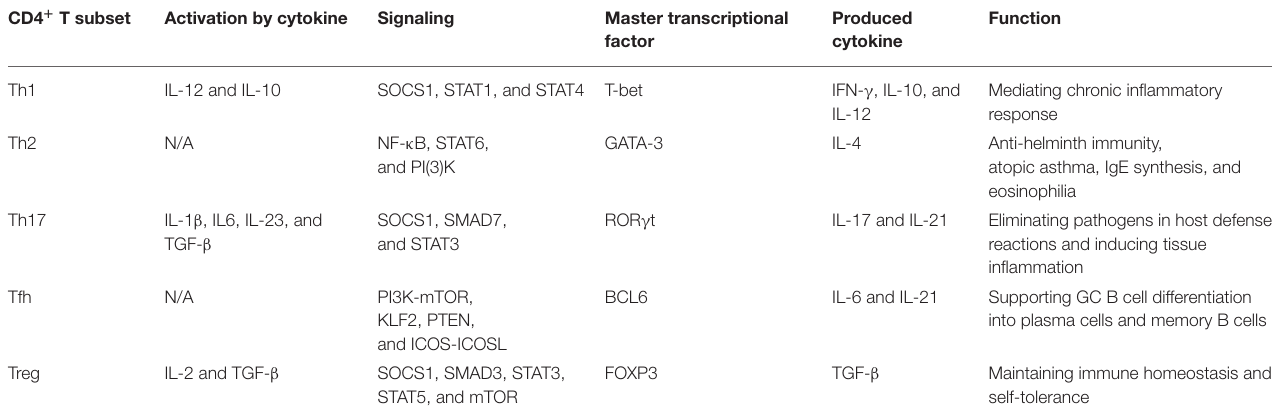
TABLE 1 | The characteristics of CD4 + T subsets.